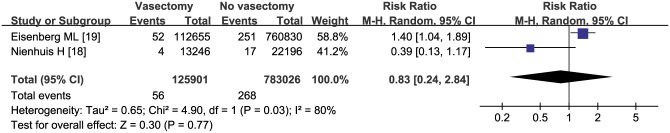
Subgroup analysis of cohort studies.